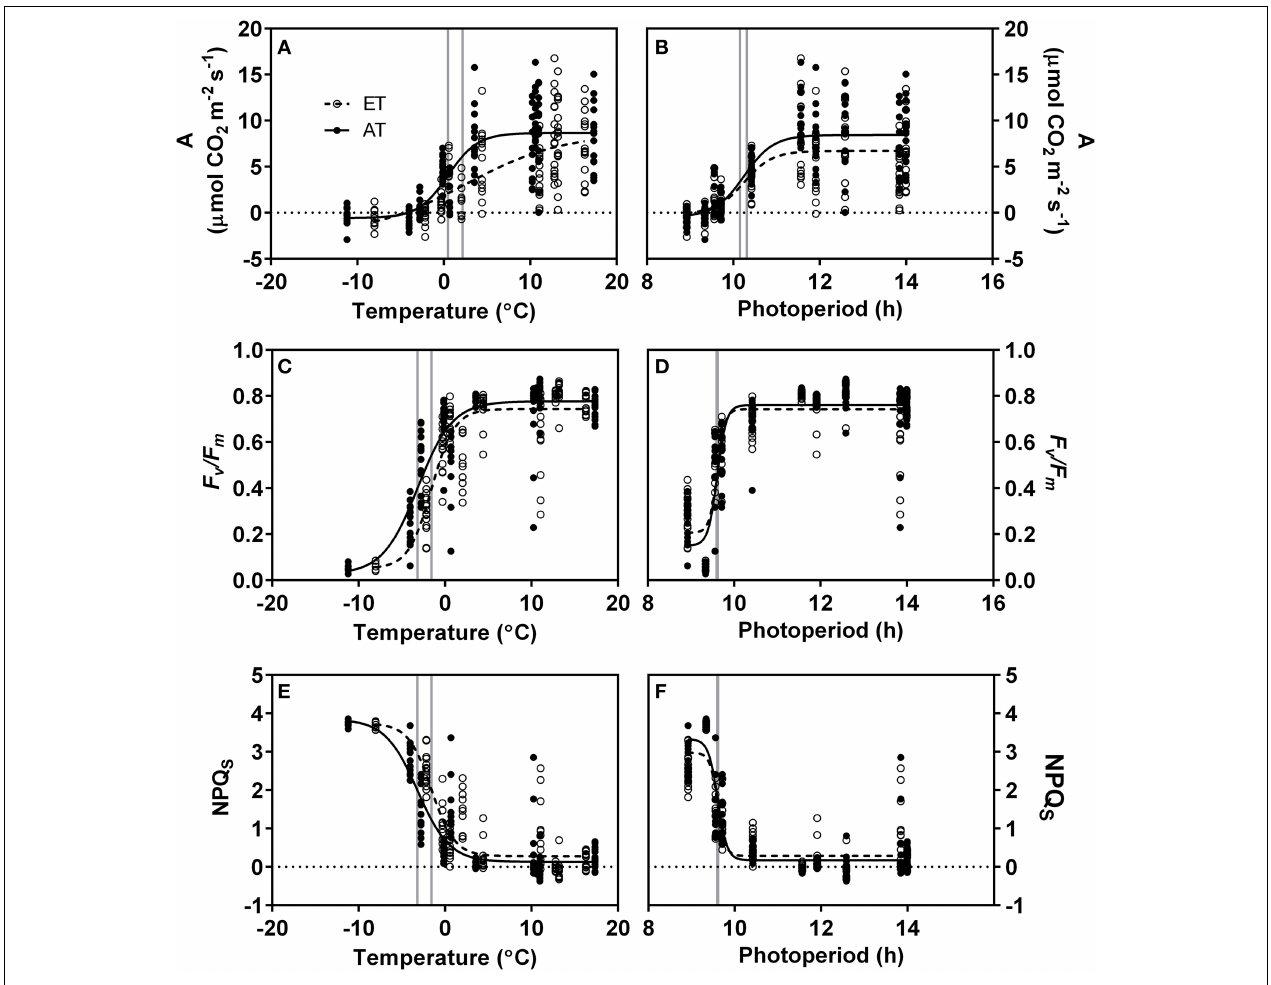
measurement. Lines represent 4-parametric sigmoidal curves fit to the data using the least-squares method. Open circles and dashed lines, elevated temperature (ET); closed circles and solid lines, ambient temperature (AT). Grey lines indicate midpoint of curve at which estimated values represent 50% of the maximum parameter